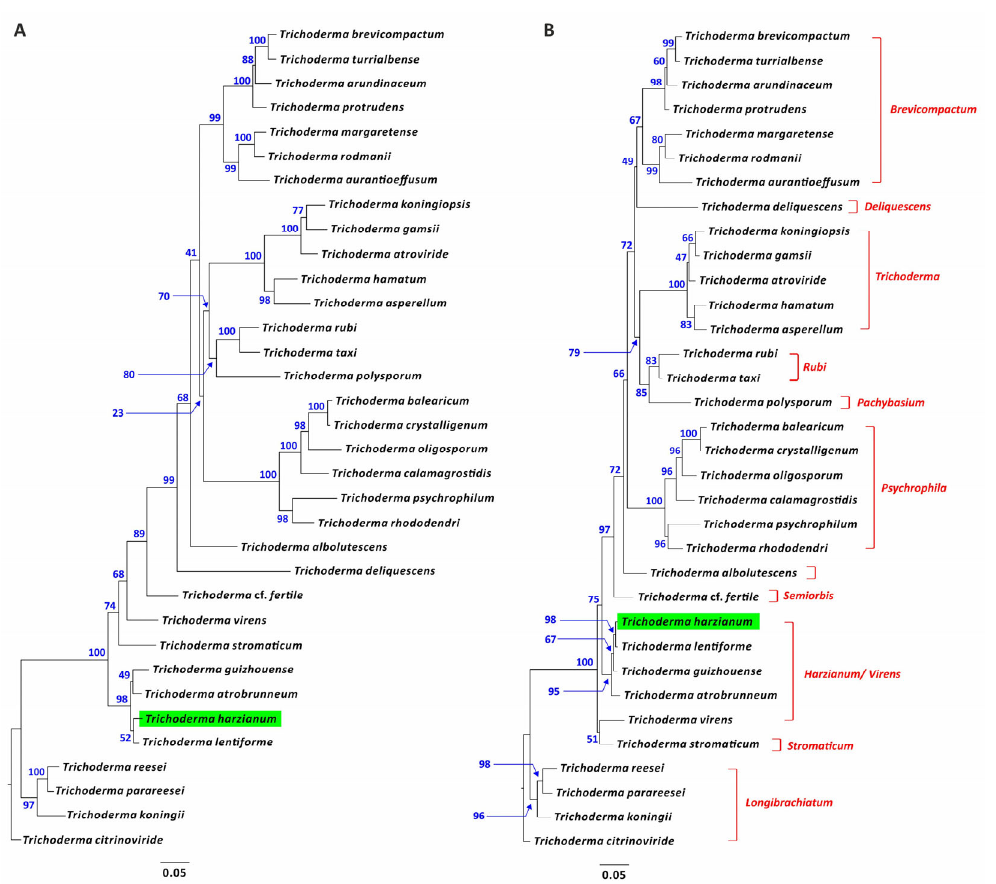
Figure 9. Maximum likelihood phylogenetic trees inferred from full ‐ length dpp1 exon ( A ) or Dpp1/DPP1 amino acid ( B ) sequences retrieved from the genome of 34 Trichoderma species that represent the known phylogenetic breadth of the genus. The trees were inferred as described in the Materials and Methods section. The numbers on each branch are bootstrap values derived from 1000 pseudoreplicates. The names of previously described subgeneric lineages [31,33] are indicated in red type at the right of the figure. The location of the T. harzianum dpp1 gene and Dpp1/DPP1 protein in the trees has been highlighted with a green rectangle. The best substitution models used to generate these phylogenetic trees were determined by the IQ ‐ Tree software as TIM3+F+I+G4 and JTTDMut+I+G4 for the nucleotide and amino acids alignments, respectively, on the basis of the optimal AICc (Akaike Information Corrected) and BIC (Bayesian Information) criteria.